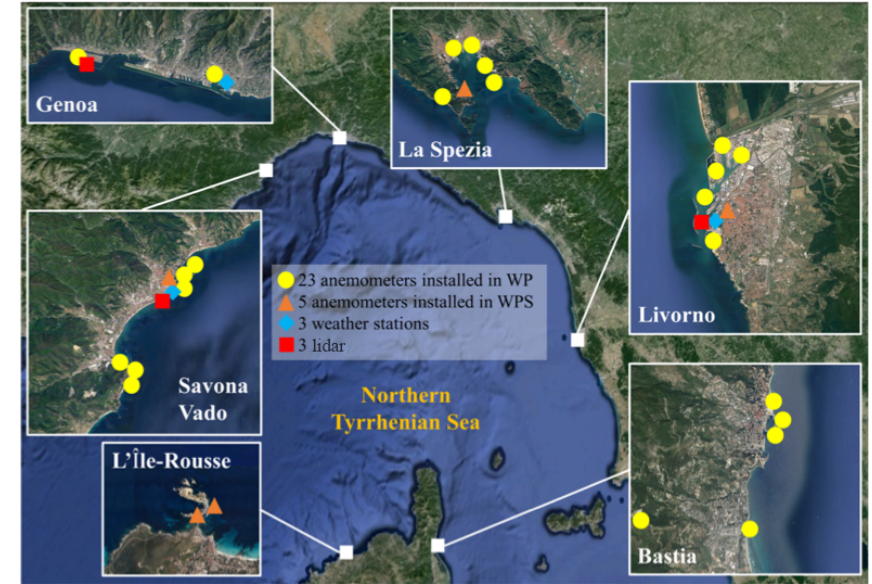
Figure 4. WP and WPS anemometric monitoring